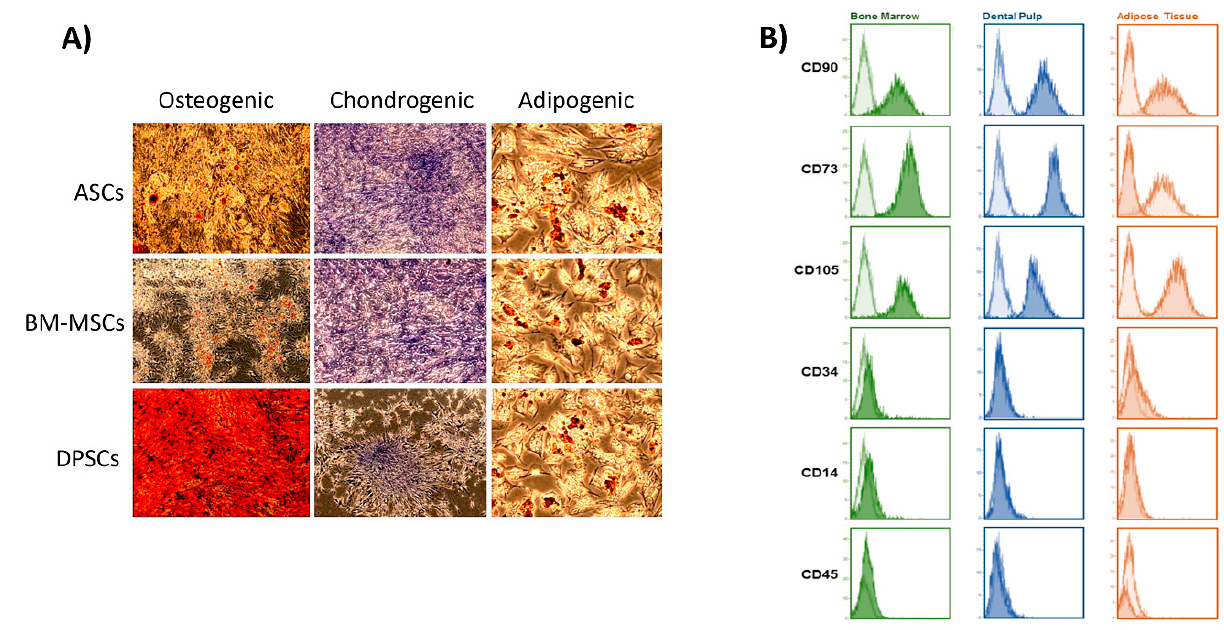
Figure A1. Characterisation of MSCs: ( A ) lineage-specific staining to confirm the correct differentiation into osteogenic, chondrogenic, and adipogenic lineages. Microscopy images show that all MSCs present the ability to differentiate into the 3 lineages; ( B ) flow cytometry results after analysing the surface marker profile of each MSC.